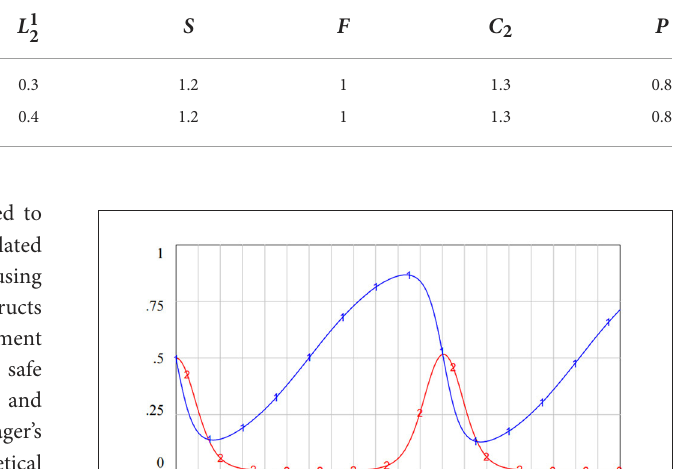
TABLE 5 The variable values.